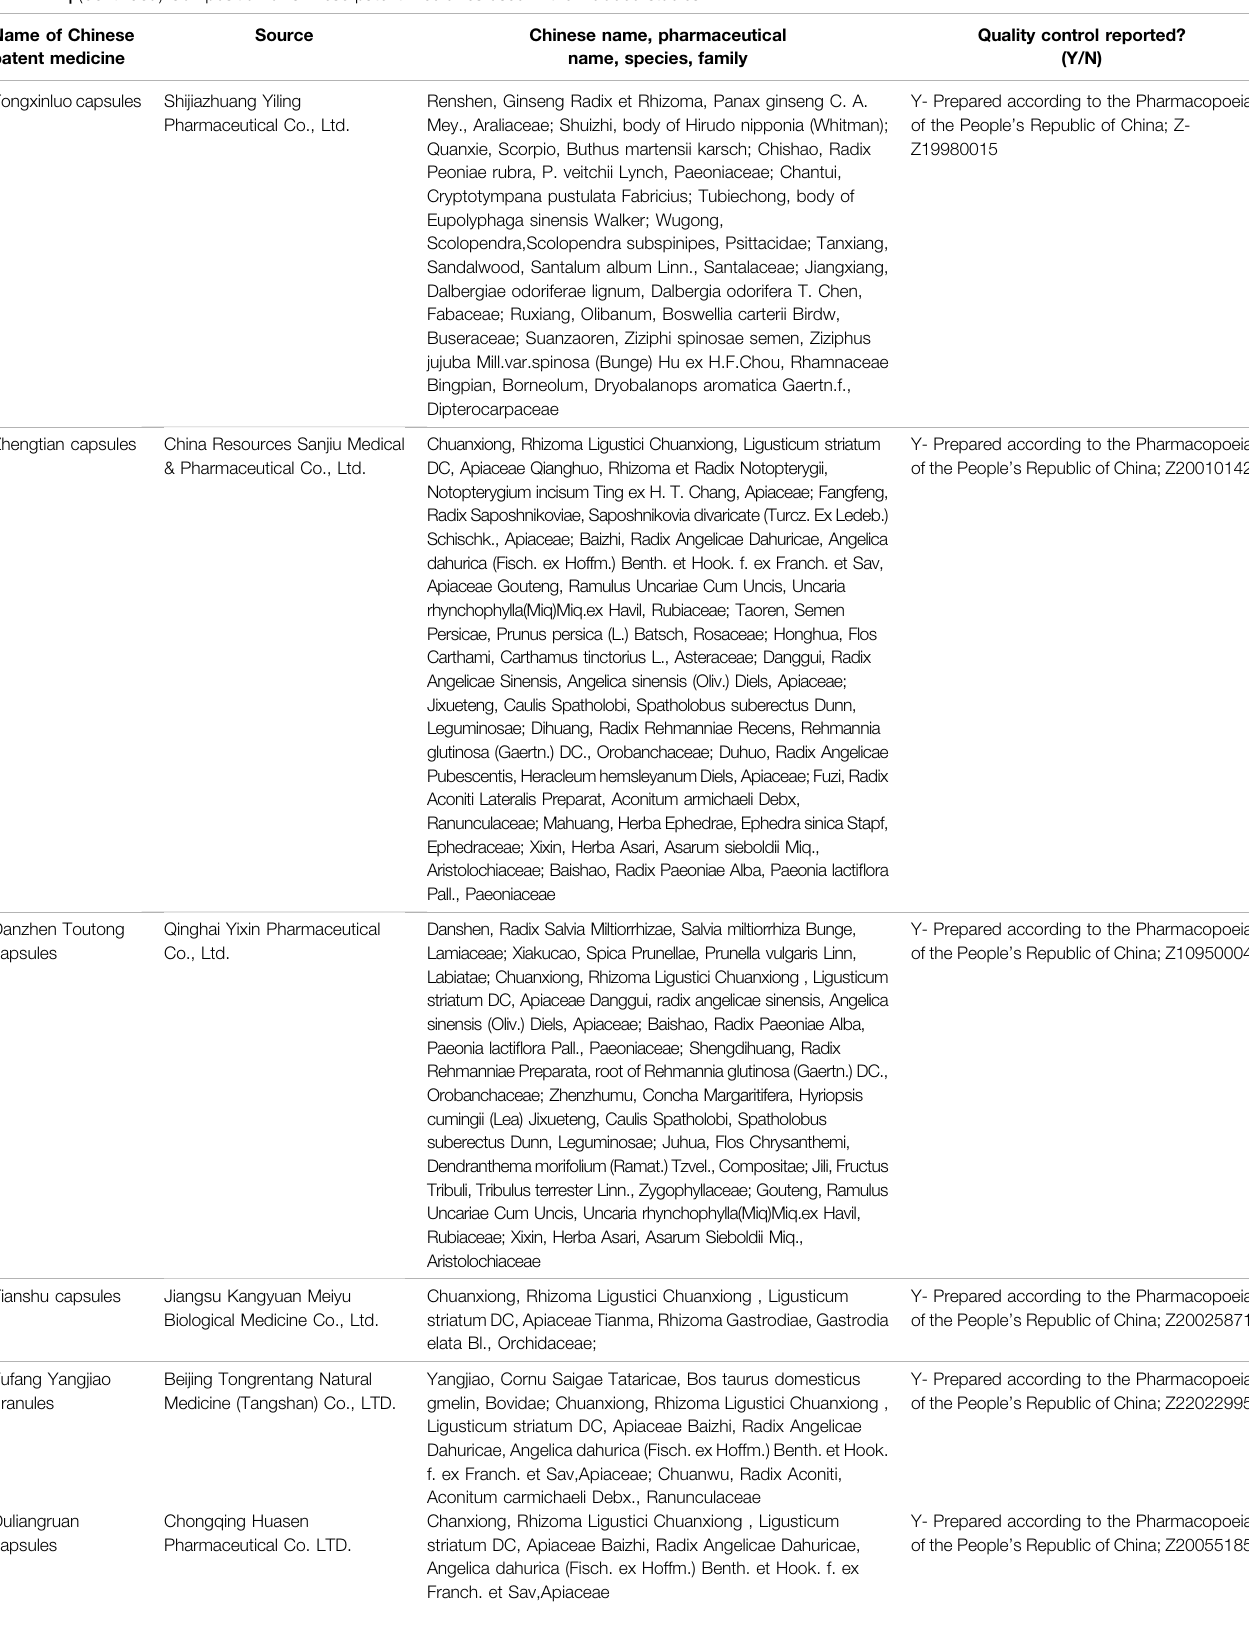
TABLE 4 | ( Continued ) Composition of Chinese patent medicines used in the included